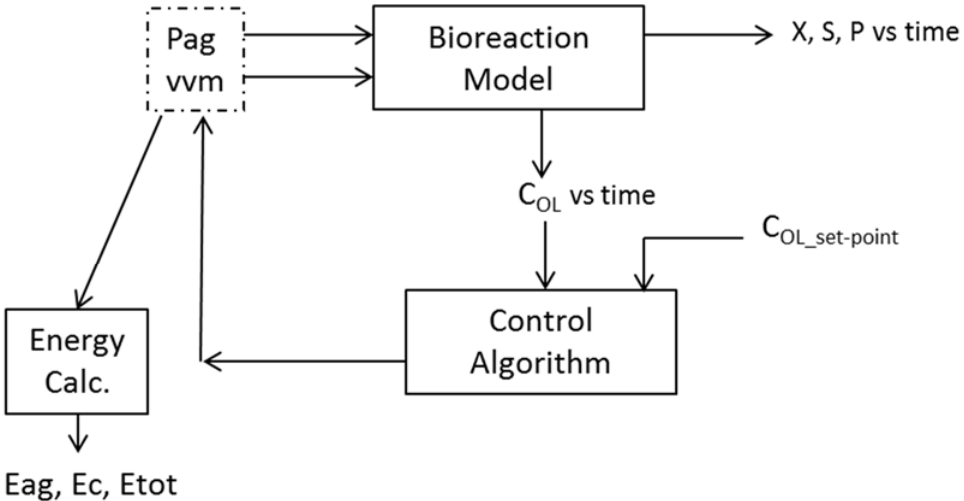
Figure 1. General schematic of control strategy.